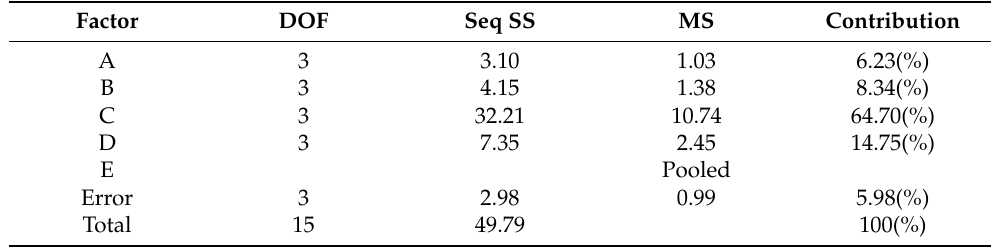
Table 13. Variance Analysis of Average Temperature